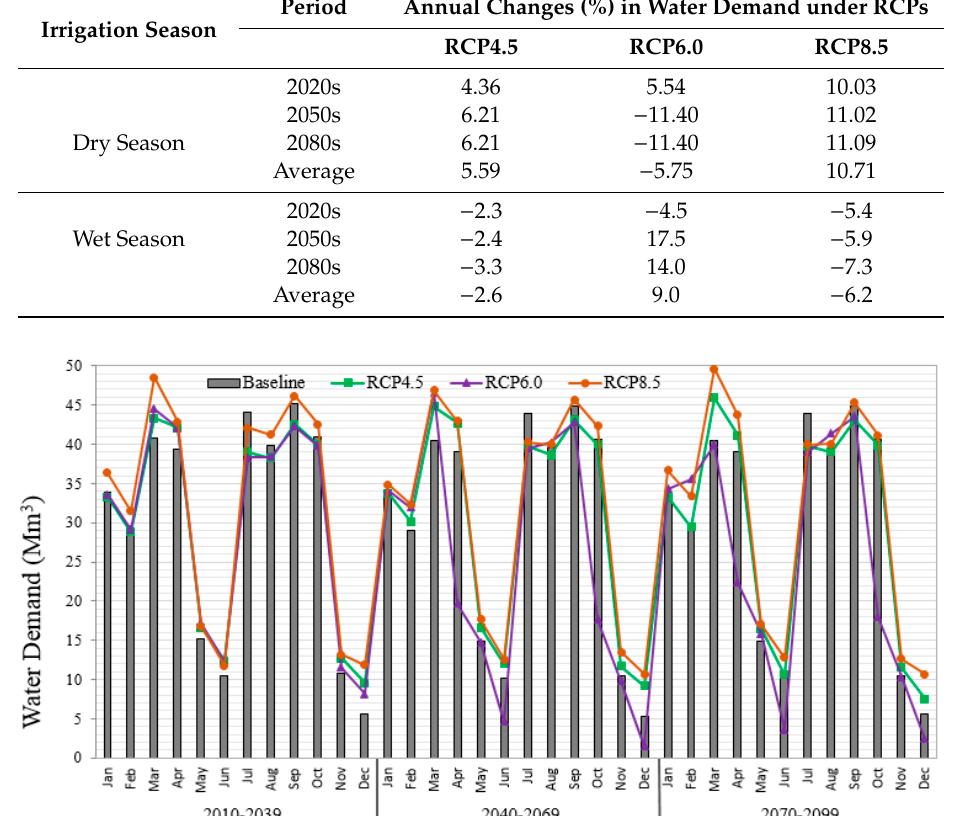
Table 5. Projected annual changes in water demand under multi-model projections based on RCP scenarios.